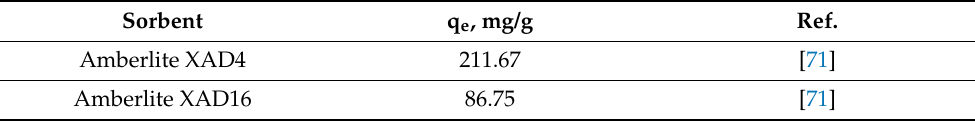
Table 6. Comparison of the effectiveness of